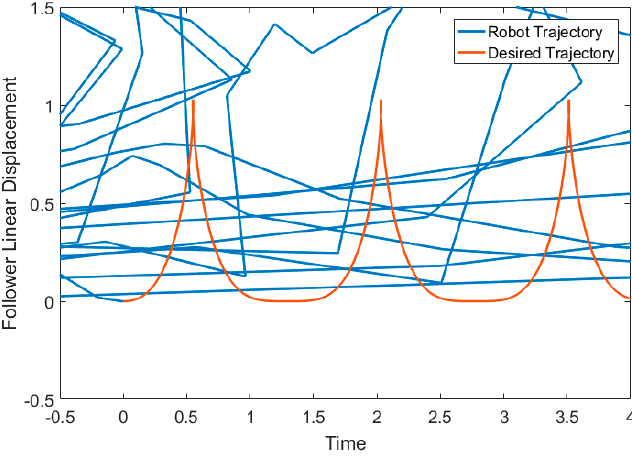
Figure 4. Obtained mean square error (MSE).